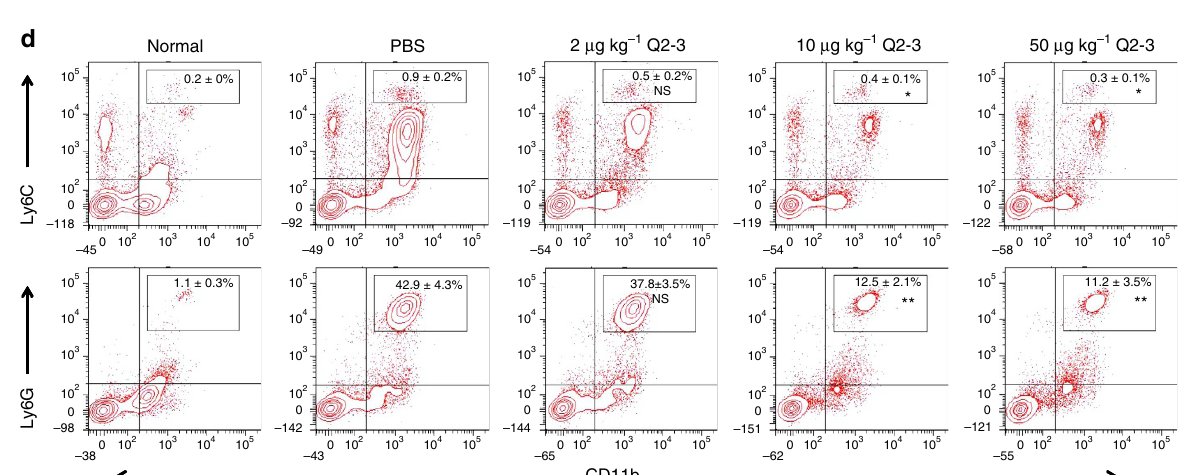
Figure 2 | In vivo treatment of Q2-3 significantly suppresses the metastasis of mouse (4T1) mammary tumour cells after a tumour resection process. ( a ) Representative bioluminescent images of tumour-bearing mice ( n ¼ 8 per group) after in vivo treatment with PBS (0.1% DMSO in saline), doxorubicin (2mgkg (cid:2) 1 ) or different dosages of Q2-3, after resection of the orthotopic primary tumours. In the PBS-treated group (vehicle), three mice died before 3 weeks post tumour resection. The red signal represents the highest level on the colorimetric scale. ( b ) Quantification of tumour metastasis by measuring luciferase activity in photonss (cid:2) 1 cm (cid:2) 2 sr (cid:2) 1 in mice revealed along the indicated time course ( n ¼ 8 per group). ( c ) Survival of test mice after different treatments. P o 0.05, were obtained between the control (DMSO) and Q2-3-treated (20 or 100 m gkg (cid:2) 1 ) groups (Kaplan–Meier results were analysed by log-rank test). ( d ) Effect of Q2-3 (2, 20 or 50 m gkg (cid:2) 1 ) on the population change of monocytic (CD11b þ Ly6C þ ) and granulocytic (CD11b þ Ly6G þ ) MDSCs in lung tissues of test mice were quantified by flow cytometry analysis, and were compared with MDSC populations in PBS group. Data are reported as mean ± s.d. ( n ¼ 3). * P o 0.05; ** P o 0.01; NS, not significant (two-tailed t -test). Similar results were obtained from three independent